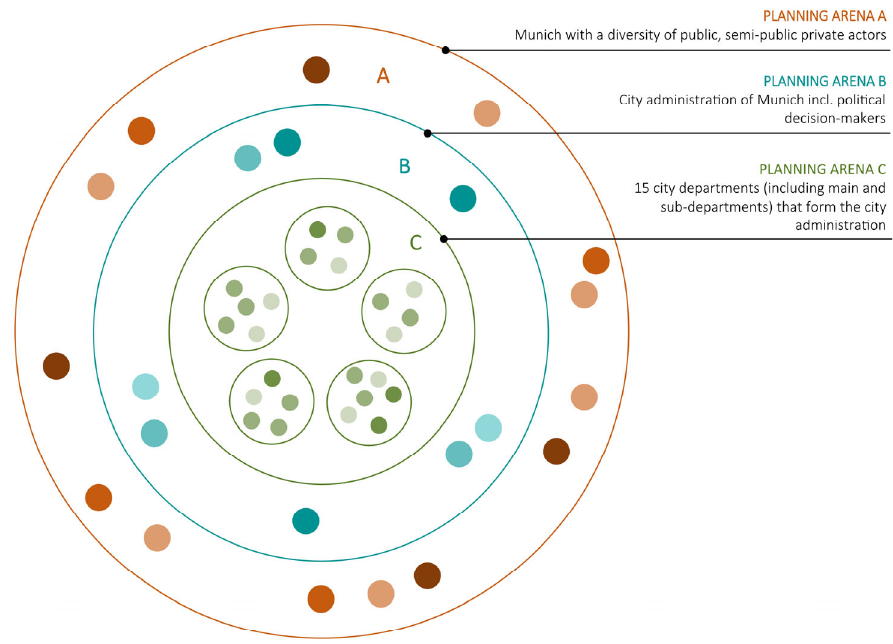
Figure 3. Planning arenas for CCA in our case study of Munich. The different shades of a colour illustrate the heterogeneity of the actors in the individual planning arenas.